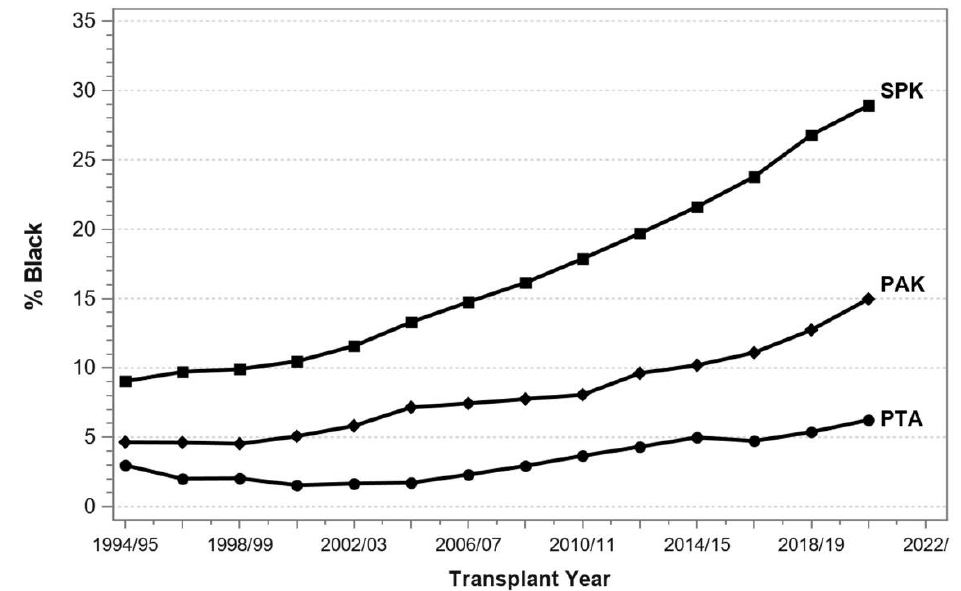
Figure 2. Proportion of African American recipients by year according to PTx category for US cases as reported to the IPTR.